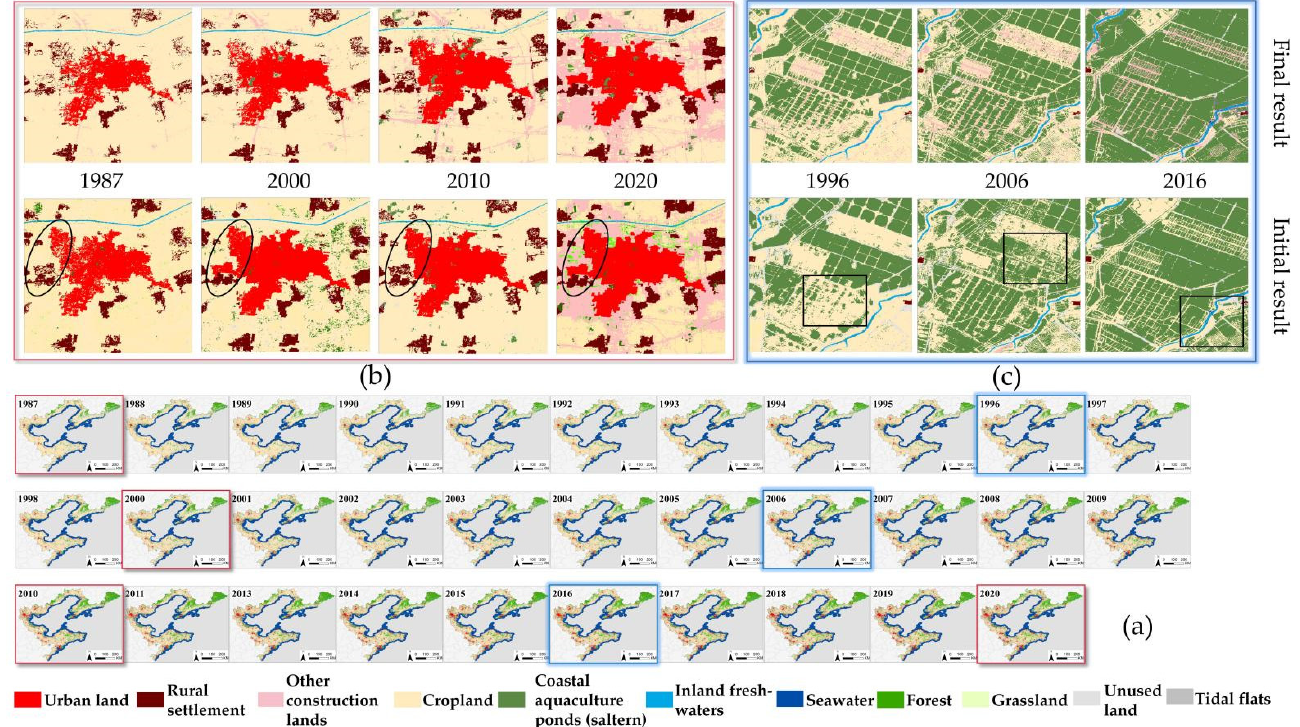
Figure 3. Long-term time series mapping result of Bohai rim coastal area: ( a ) results of annual classification; ( b ) comparison of the results of urban land expansion; ( c ) comparison of the results of aquaculture ponds (saltern) in different years. Table 2. Transfer matrix of land use change in Bohai rim coastal area from 1987 to